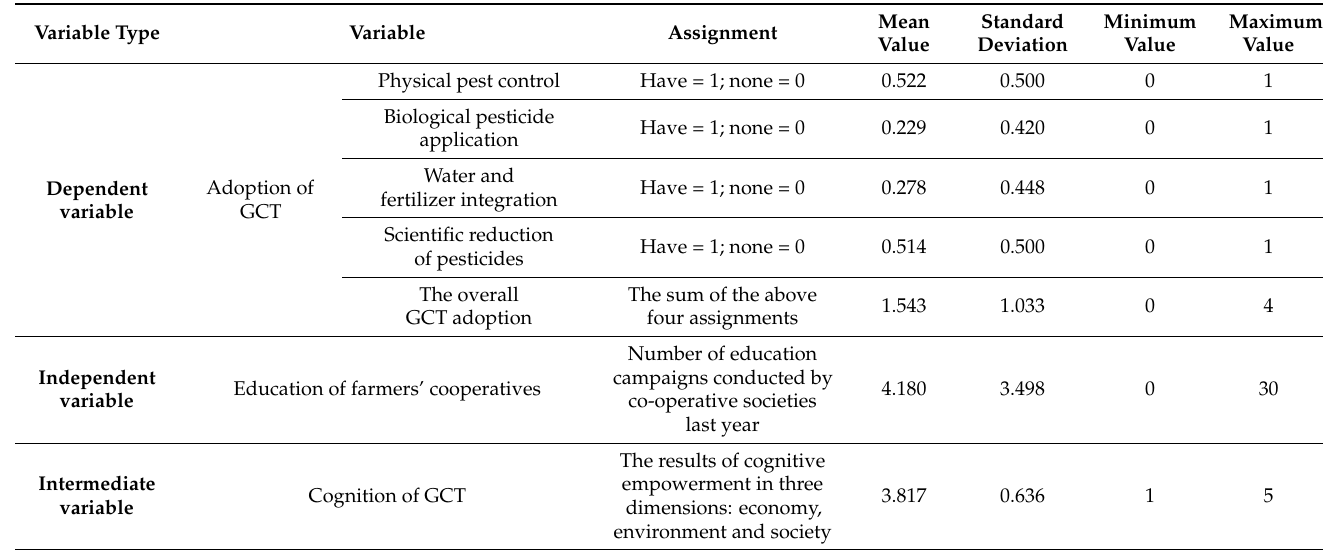
Table 3. Meaning and assignment of